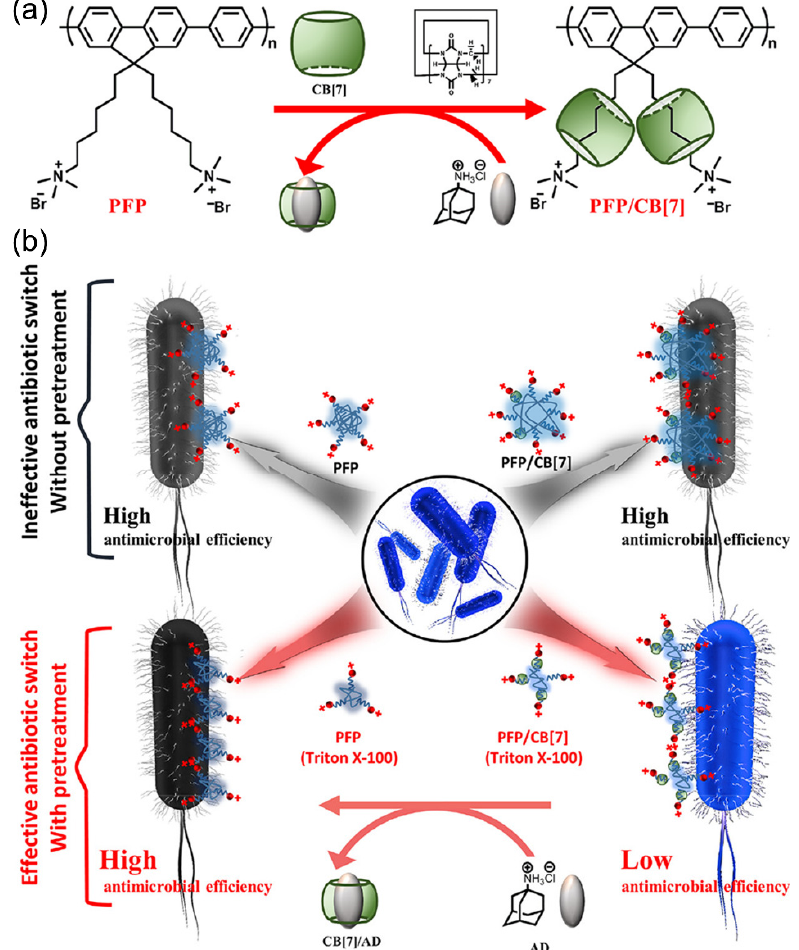
Figure 8. ( a ) The supramolecular assembly process between PFP and CB [7] and the de-assembly process of PFP/CB [7] complex after adding AD. ( b ) Schematic diagram of antimicrobial process of PFP/CB [7] before and after Triton X-100 pretreatment. Reprinted with permission from Ref. [49]. Copyright 2017 American Chemical Society.